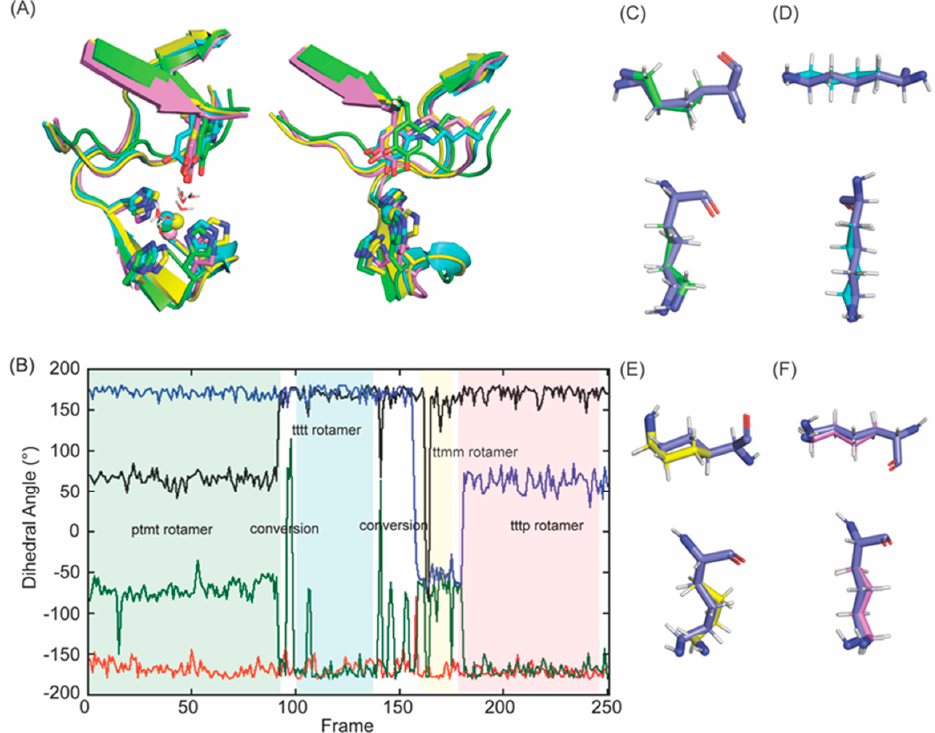
Figure 11. Molecular modeling and energy minimization of a 3D − model of the resting form of Δ 1 − 2SRCR − LOXL2 in comparison to the structure obtained from MD − simulation. ( A ) An overlaid view of LTQ and Cu 2+ − binding site in four distinct configurations (frame 72: in green; frame 150: in cyan; frame 200: in yellow; frame 251: in pink in ( B )). ( B ) Dihedral angles of Lys653 throughout the MD − simulation Χ 1 (dihedral angle between N − C α− C β− C γ ) (black) X2 (dihedral angle between C α− C β− C γ− C δ ) (red) X3 (dihedral angle between C β− C γ− C δ− C ϵ ) (green) X4 (dihedral angle be- tween C γ− C δ− C ϵ − N ζ ) (blue). We observed four stable rotamers (ptmt, tttt, ttmm, tttp) among the ideal rotamers reported for Lys653: t stands for the side chain dihedral angles of 180°, p stands for the side chain dihedral angles of 65°, and m stands for the side chain dihedral angles of − 65° [31]. ( C ) An overlaid view of Lys653 in frame 72 after MD − simulation (in green) with the ptmt rotamer (in slate). ( D ) An overlaid view of Lys653 in frame 125 after MD − simulation (in cyan) with the tttt rotamer (in slate). ( E ) An overlaid view of Lys653 in frame 170 after MD − simulation (in yellow) with the ttmm rotamer (in slate). ( F ) An overlaid view of Lys653 in frame 225 after MD − simulation (in pink) with the tttp rotamer (in slate).